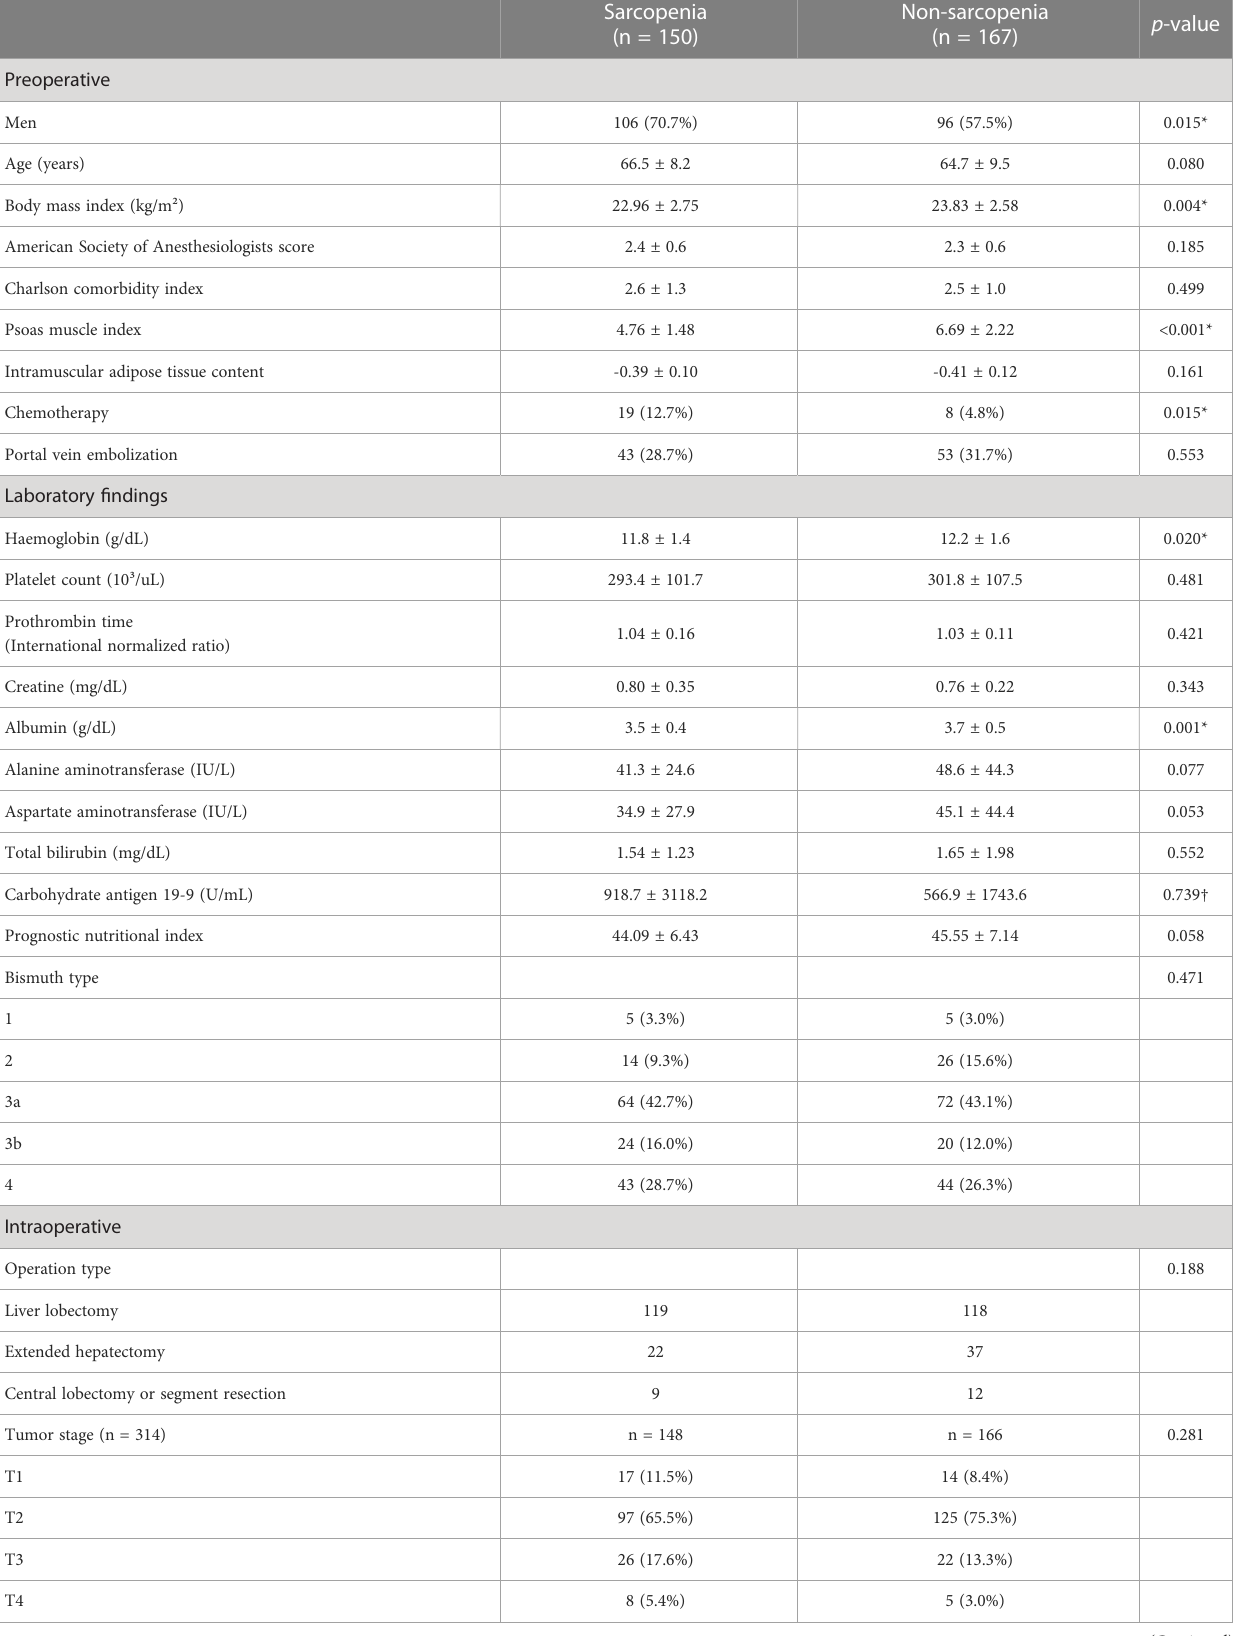
TABLE 2 Association between preoperative sarcopenia and perioperative